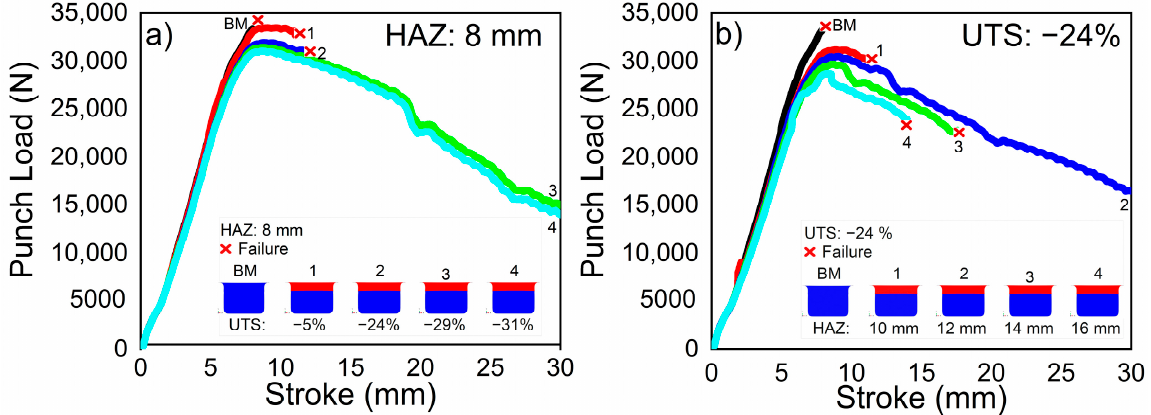
Figure 9. Punch load and punch displacement of the reference model and several heat treatment conditions. ( a ) Varying material softening degree and ( b ) modifying the heat-affected zone dimen- sion.